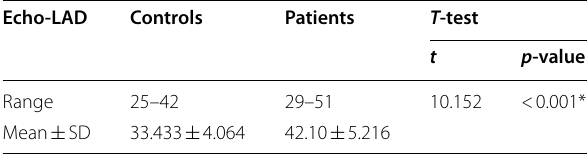
Table 3 Evaluation of LAD in both groups